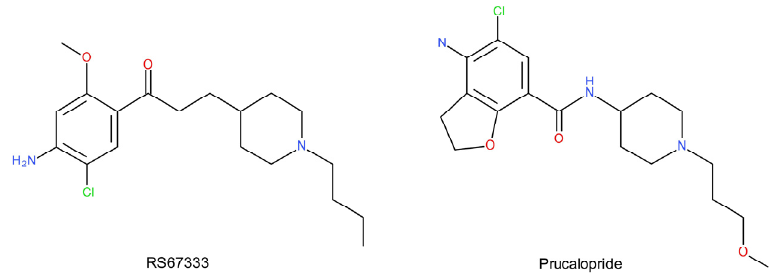
Figure 8. 5-HT 4 receptor agonists: RS67333 and